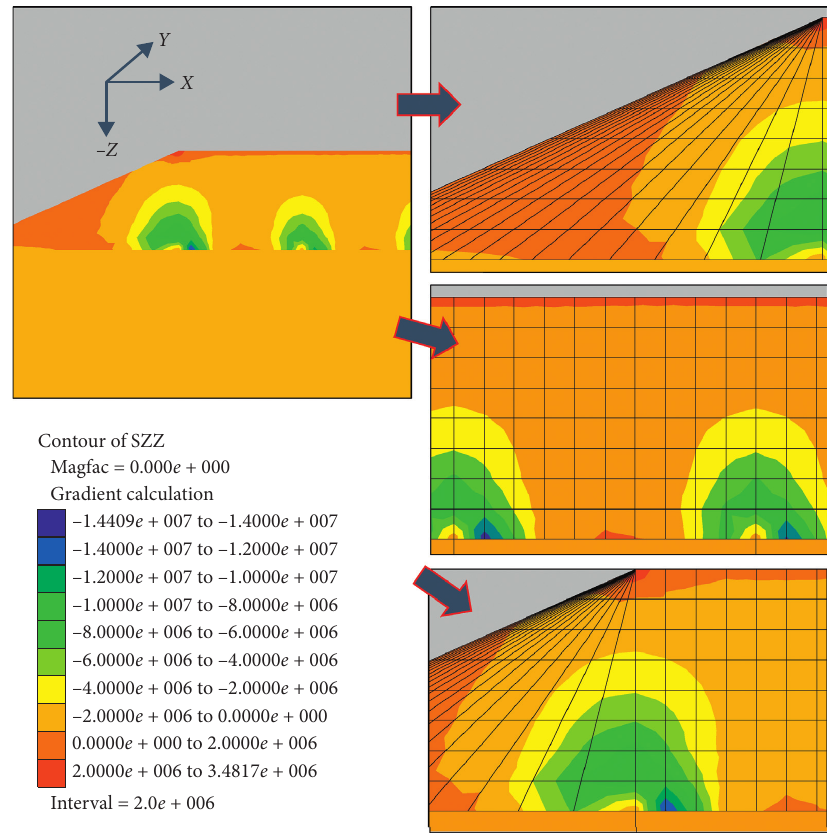
Figure 8: Cloud chart of vertical stress after